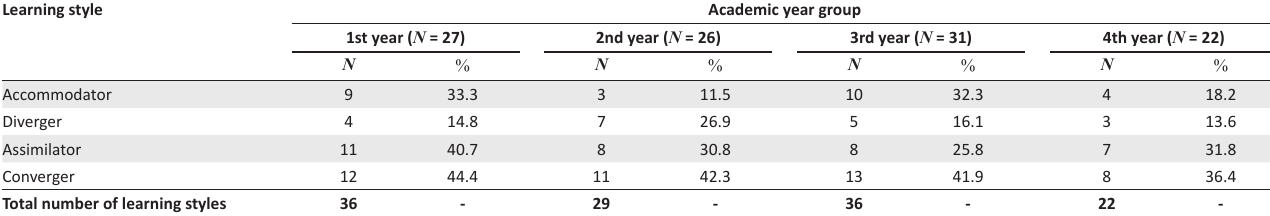
FIGURE 3: Distribution of learning styles ( N = 123) among undergraduate optometry students at the University of the Free State in 2014 ( N = 106). TABLE 1: Distribution of learning styles per academic year group of optometry students at the University of the Free State in 2014 ( N = 106). Learning